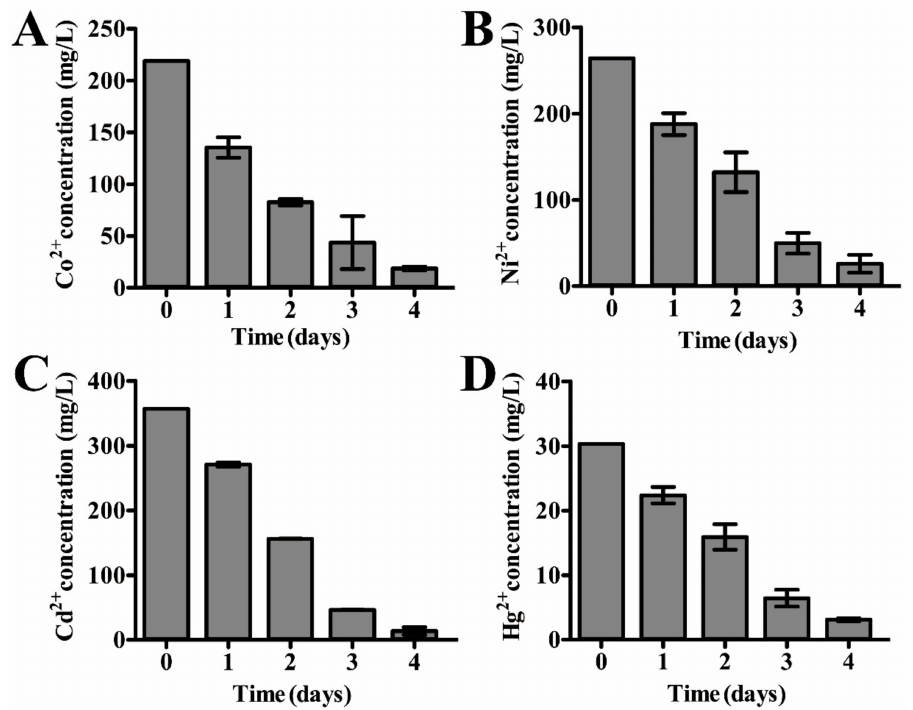
Figure 3. Measurement of the removal efficiency of heavy metals by P. cashew SRB007. The concentrations of Co 2+ ( A ), Ni 2+ ( B ), Cd 2+ ( C ) and Hg 2+ ( D )were measured at 0, 1, 2, 3 and 4 d, respectively. The removal efficiency was calculated as described in the method